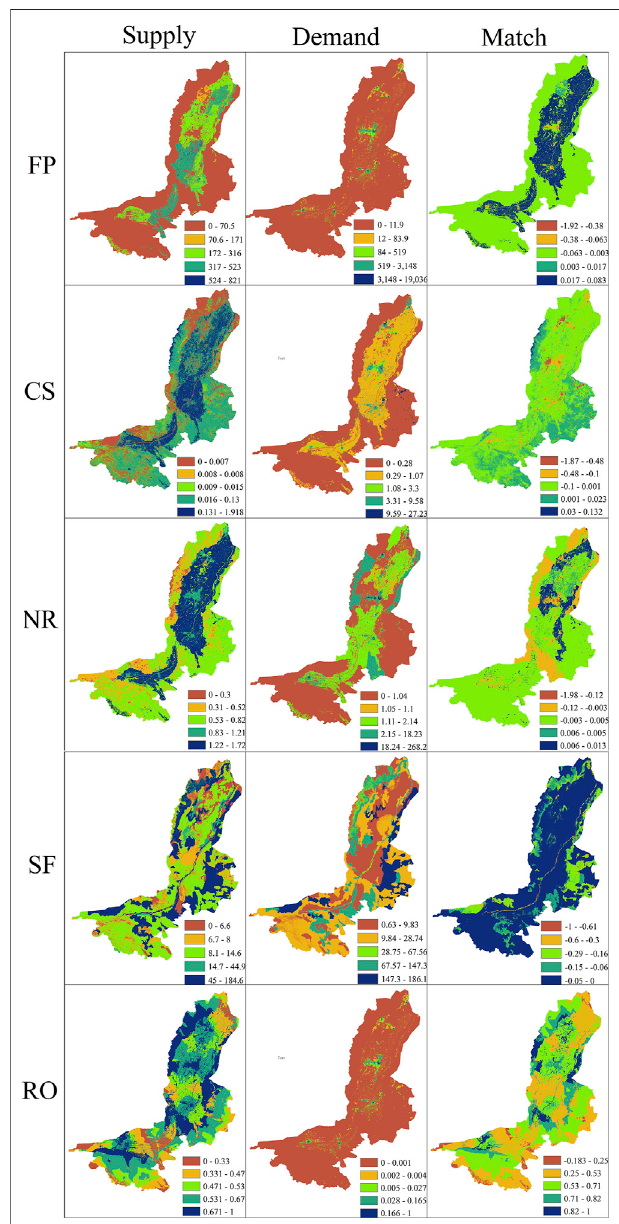
FIGURE 3 | Spatial distribution of ES supply, ES demand, and ESDR in ( Figure 4 ). Among the 10 pairs of ESs, only one pair (crop production and nutrient retention) exhibited consistent synergies with different strengths across the three sides. Three pairs (crop production vs carbon sequestration, carbon sequestration vs nutrient retention, sand fi xation vs nutrient retention) exhibited opposite correlations between the supply and demand sides and the match side. Sand fi xation and other ESs exhibited weak correlations at the supply and demand sides but strong synergies with crop production and nutrient retention and strong tradeoffs with carbon sequestration and recreational